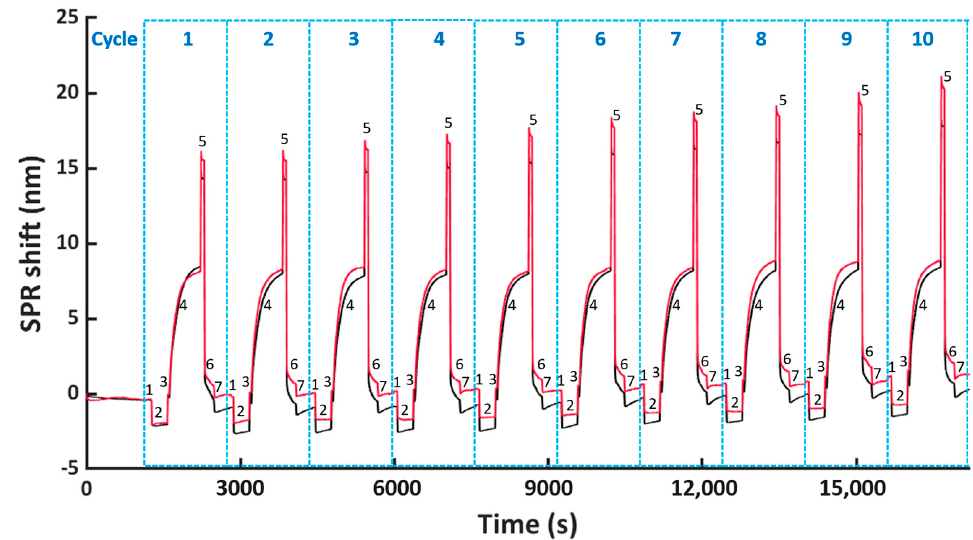
Figure 6. The FO-SPR sensorgram obtained from two parallel FO probes representing ten regeneration cycles of His 6 − tagged scFv − 33H1F7, including the following steps: (1, 3 and 7) TBS stabilization, (2) formation of the Co(II) − NTA chelate, (4) immobilization of scFv − 33H1F7 at 20 µ g/mL, (5) removal of scFv − 33H1F7 and (6) washing with NaOH, using the optimized regeneration protocol (i.e., condition G combined with 3 min washing in 0.5 M